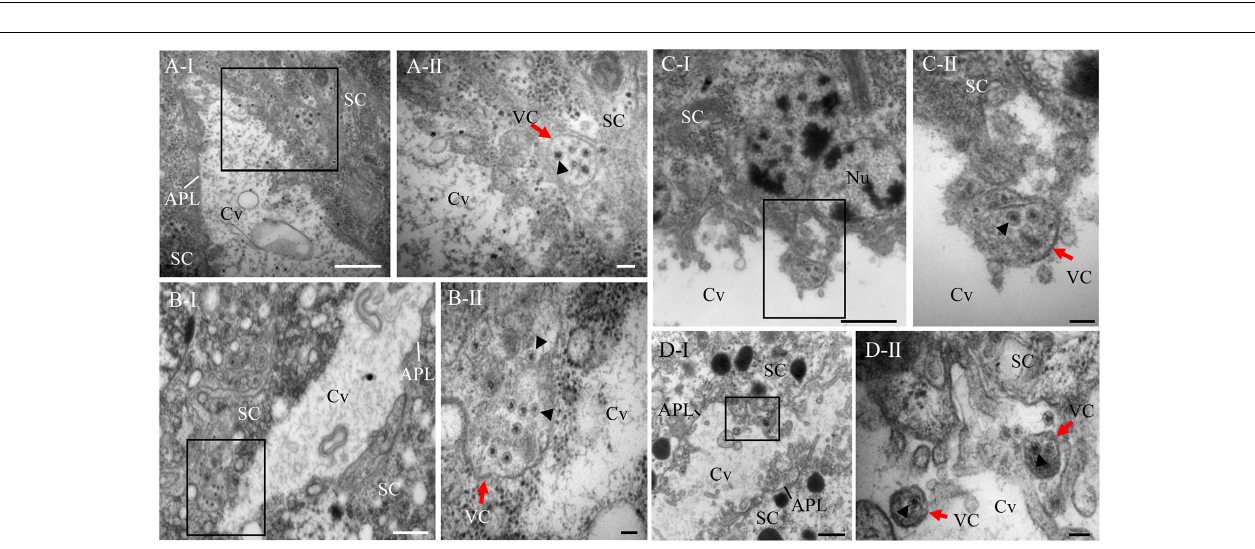
FIGURE 3 | Electron micrographs demonstrating the entry of RDV into cavities by utilizing vesicular compartments via an exocytosis-like process. (A) Virus-laden vesicular compartments within the cytoplasm of salivary gland cells. (B) Virus-laden vesicular compartments in the cytoplasm moving close to the salivary cavities. (C) Virus-laden vesicular compartments enter into the salivary cavities by fusing with the apical plasmalemma. (D) Virus-laden vesicular compartments interspersing within the salivary cavities. Red arrows indicate virus-laden vesicular compartments. Black arrow heads indicate the virions in vesicular compartments. Panels II are enlarged images of the boxed areas in panels I of (A–D) , respectively. SC, salivary cytoplasm; APL, apical plasmalemma; Cv, cavity; VC, vesicular compartment. Bars, 500 nm (A-I,B-I,C-I,D-I) , and 100 nm (A-II,B-II,C-II,D-II)